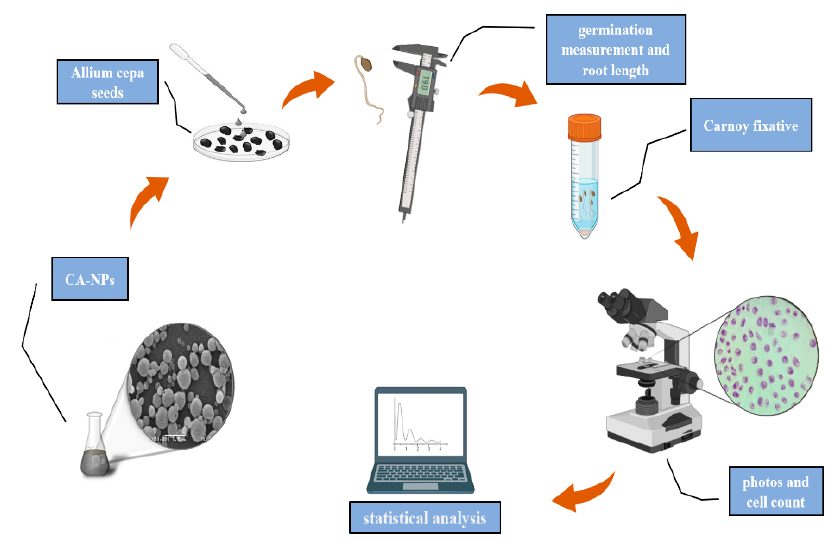
Figure 1. Schematic diagram of the Allium cepa assay.